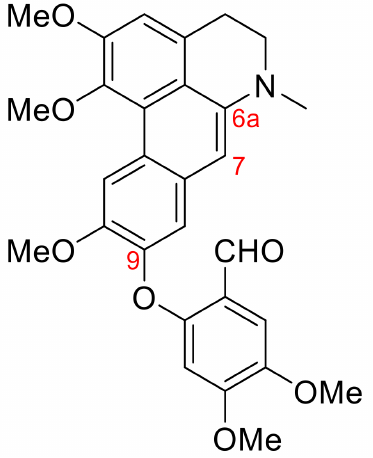
Figure 6. Structure of 6a,7-dehydrohernandaline ( 59